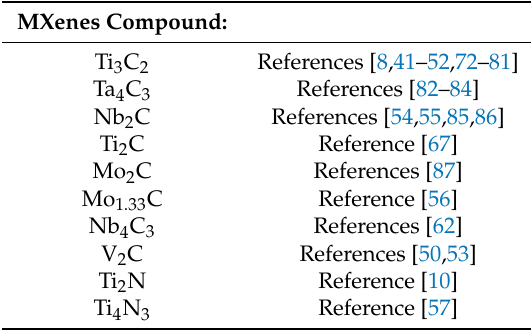
Table A1. The types of delaminated 2D MXenes compounds used in this study. The information about the particular compound are presented in details in the following